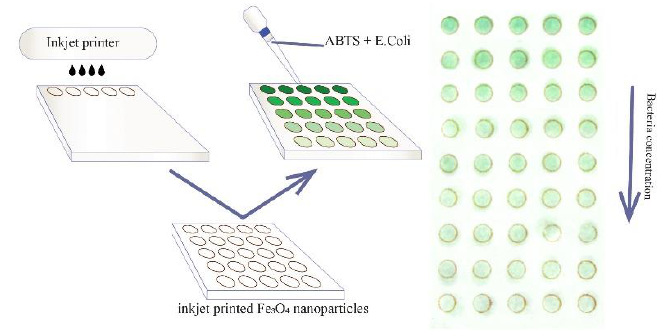
Figure 1. Principal scheme of the analytical system proposed.